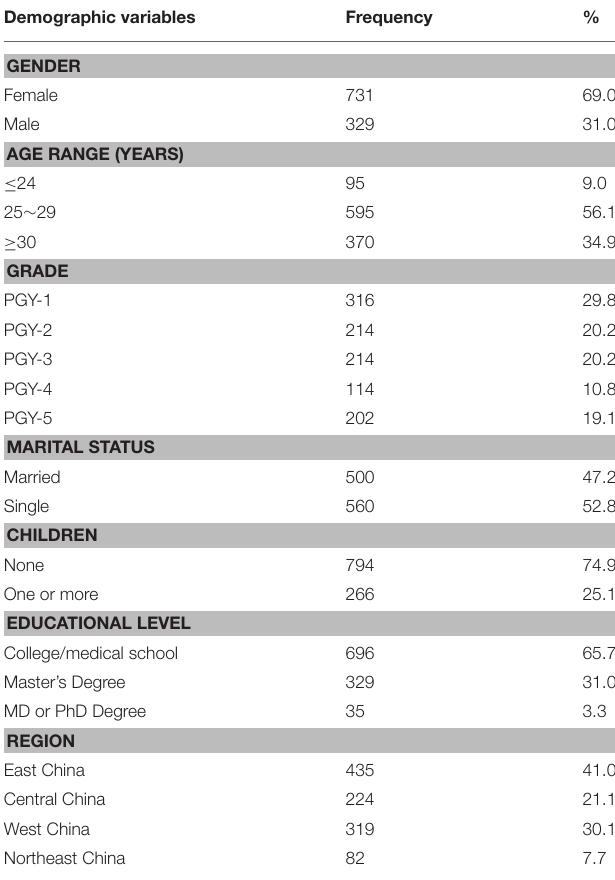
TABLE 1 | Demographic characteristics of psychiatry residents ( N =